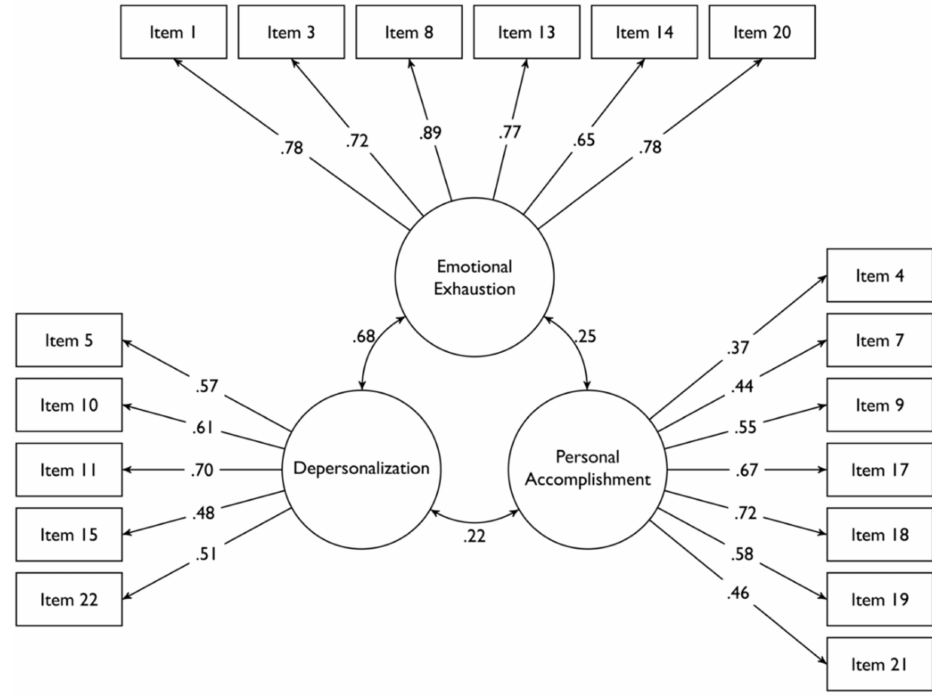
Figure A2. Factor structure of the refined version of the Maslach Burnout Inventory.